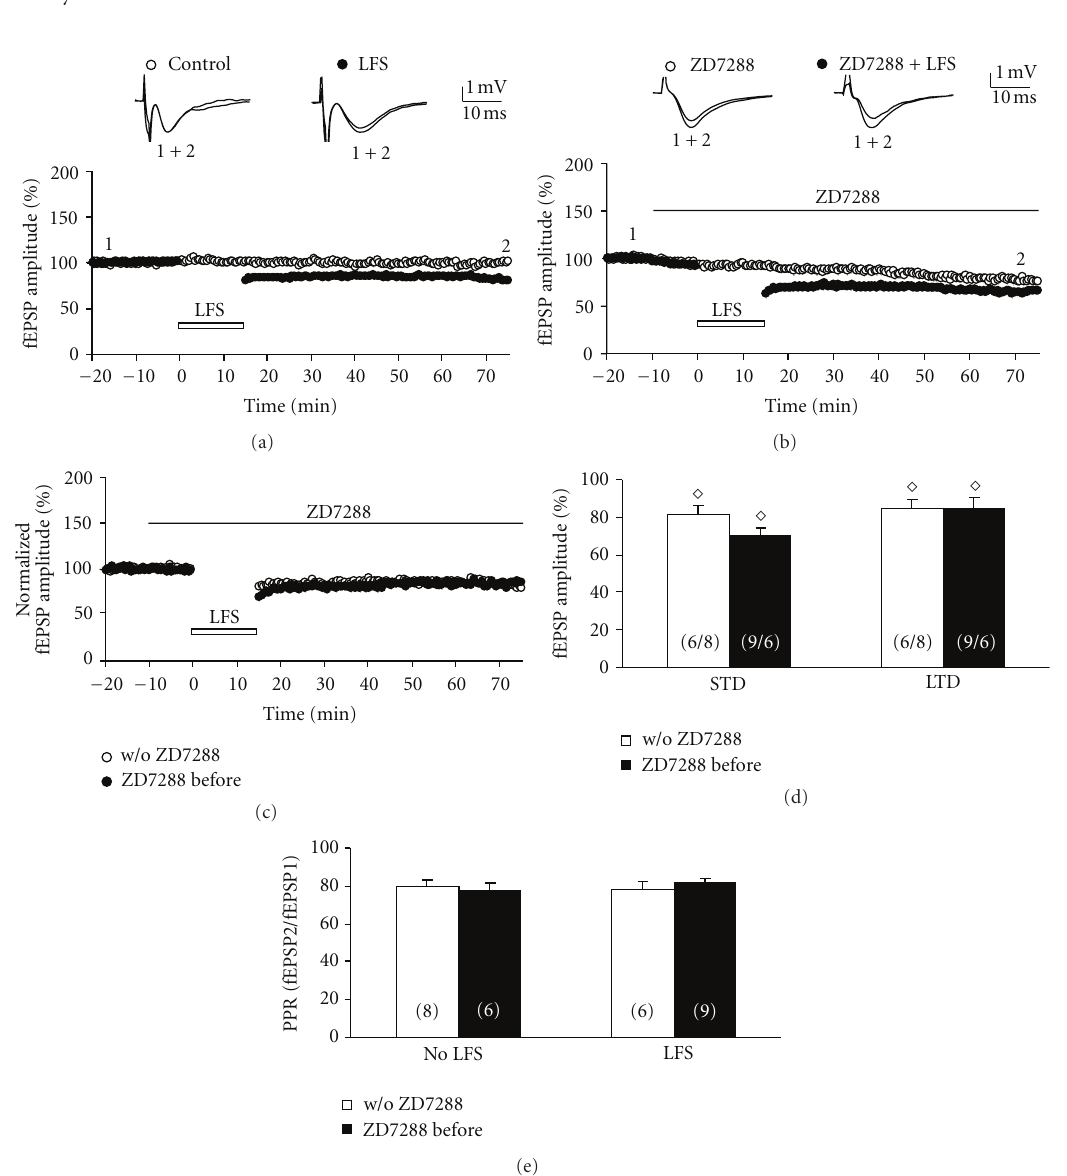
Figure 2: ZD7288 has no e ff ect on LFS-induced LTD in adult rats. (a) The time course of the fEPSP amplitude following LFS in adult rats (P30–60) shows LTD (closed symbols) as compared to time-control experiments without LFS (open symbols). Representative fEPSPs were taken at the beginning (indicated by “1”) and at the end (indicated by “2”) of the experiment. (b) Comparing the fEPSP amplitude time course following ZD7288 treatment (starting 10min prior to LFS, indicated by a closed bar) between LFS-treated (closed symbols) and non- LFS-treated time-control experiments (open symbols) reveals a synaptic depression which was similar to that in non-ZD7288 conditions shown in (a). (c) Normalized time courses of fEPSP amplitudes in both conditions: without ZD7288 (open symbols) and ZD7288 before LFS (closed symbols). Note that similar levels of LFS-induced STD and LTD were obtained in both slices without ZD7288 and slices with ZD7288 before LFS. (d) The bar graph summarizes the STD and LTD levels in both ZD7288 and non-ZD7288 conditions. The number of slices is given in parentheses (number of LFS-treated slices/number of non-LFS-treated slices). (e) The bar graph summarizes the paired- pulse ratio of all experimental groups recorded at the beginning of each experiment, that is, before ZD7288 and/or LFS were applied to the slices. Note that the PPR was similar in all groups. All data are mean ±